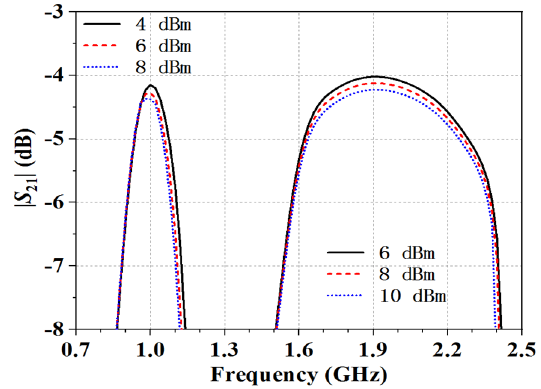
Figure 12. Measured IIP3 versus frequency.